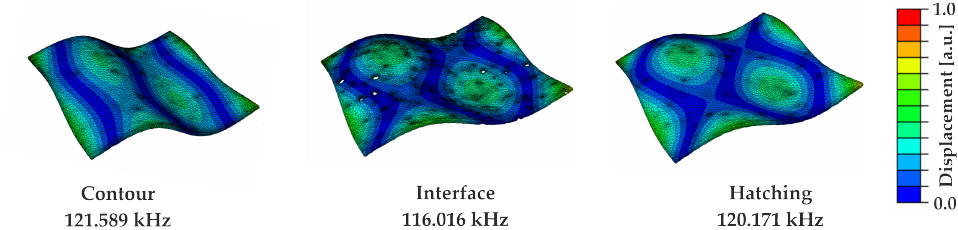
Figure 13. Modal shape comparison of the sixth overall mode of models representing the three characteristic regions of a vertically built sample. For better visualization, the shown displacements are scaled. The differences in the mode frequency relative to the hatching area are 1.2% for the contour area and 3.5% for the interface area. In Figure 14, the results of the fitted elastic constants C 11 and C 44 in each of the different regions for samples built under various construction angles are summarized.